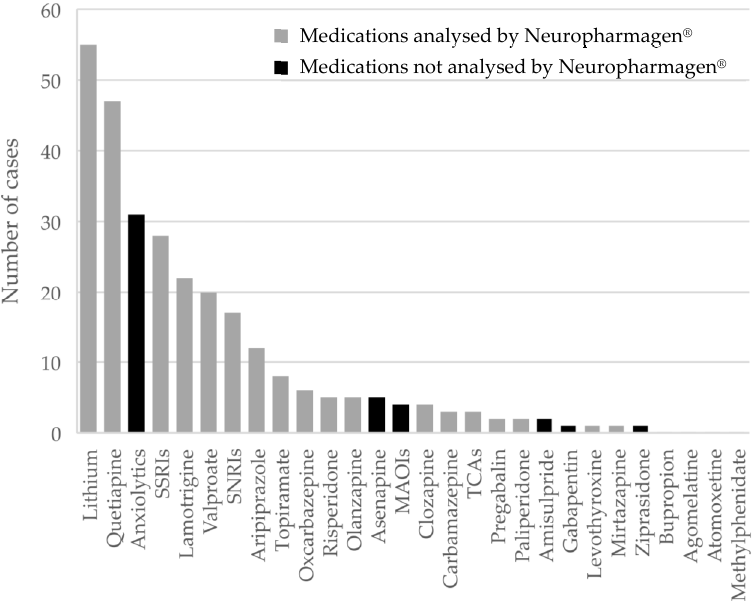
Figure 2. Medications for treating the index episode ( n = 76). MAOI: Monoamine Oxidase Inhibitor; SNRI: Serotonin-Norepinephrine Reuptake Inhibitor; SSRI: Selective Serotonin Reuptake Inhibitor; TCA: Tricyclic Antidepressant.